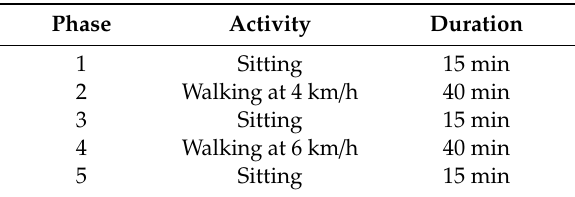
Table 2. Phases during wear trials.